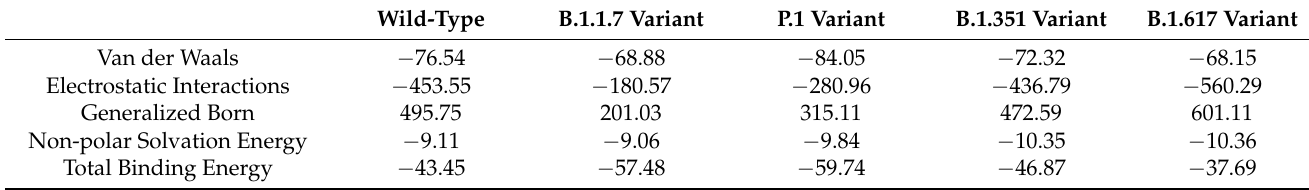
Table 2. MM/GBSA binding free energies of the wild-type and all the variants. All energy values are presented in kcal/mol.